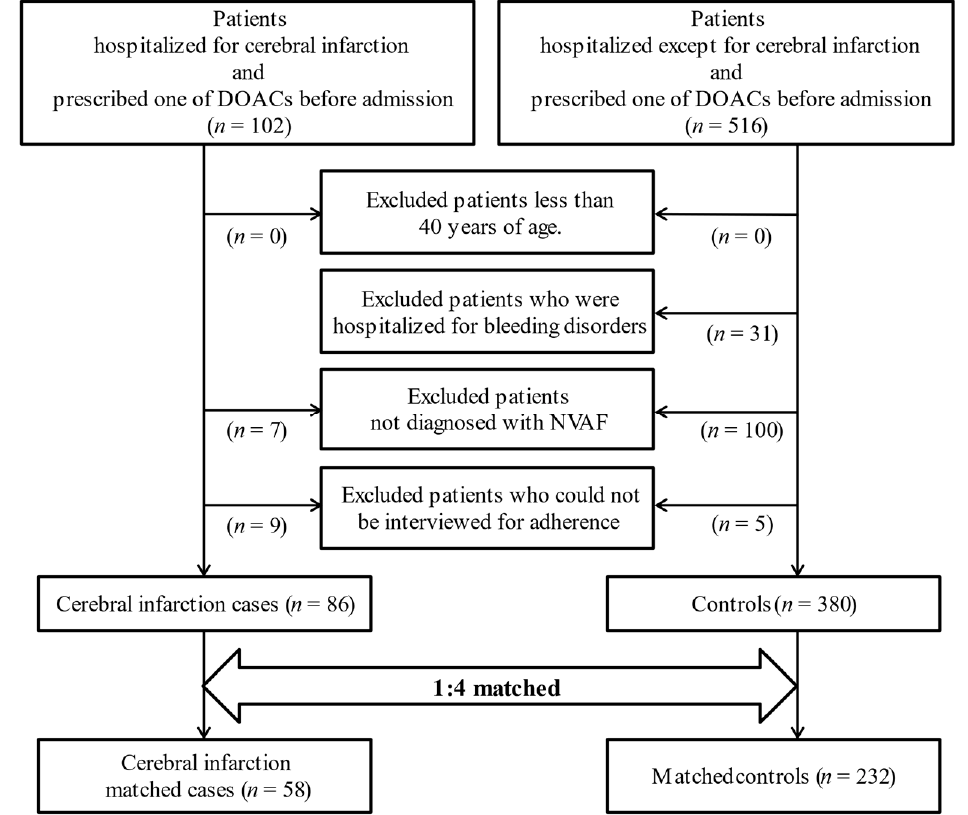
Figure 1. Flowchart of this study. DOAC, direct oral anticoagulant; NVAF, non-valvular atrial fibrillation. Table 1. Clinical characteristics of the study patients (before matching).